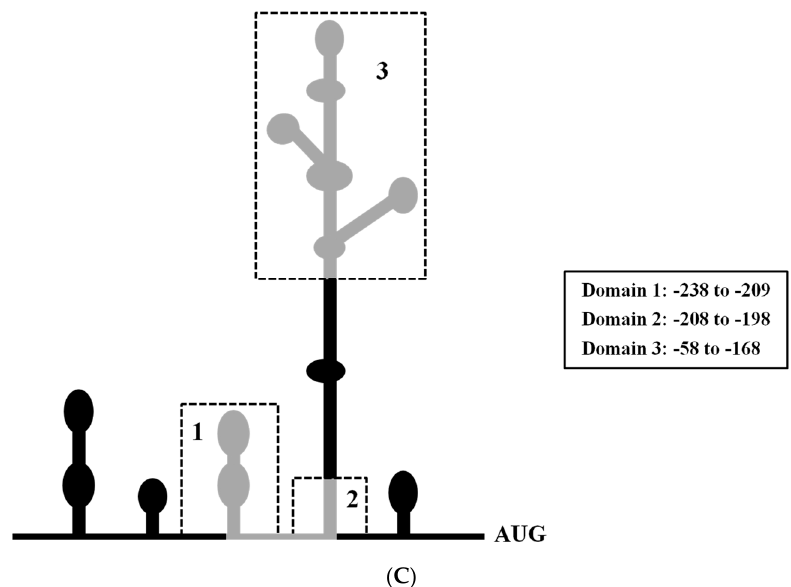
Figure 5. Mapping the RRBP1 IRES. ( A ) Schematic representation of the 5 ′ - and 3’-deleted regions of the RRBP1 5 ′ UTR and these regions were inserted into pRF between Renilla and firefly luciferase reporter genes; ( B ) IRES activity of different truncated RRBP1 sequences in HEK293 and Bel7402 cell lines. The expression data are presented as the mean ± SEM of triplicate samples; and ( C ) schematic representation of the RRBP1 IRES, organized in domain 1–3 (grey line).